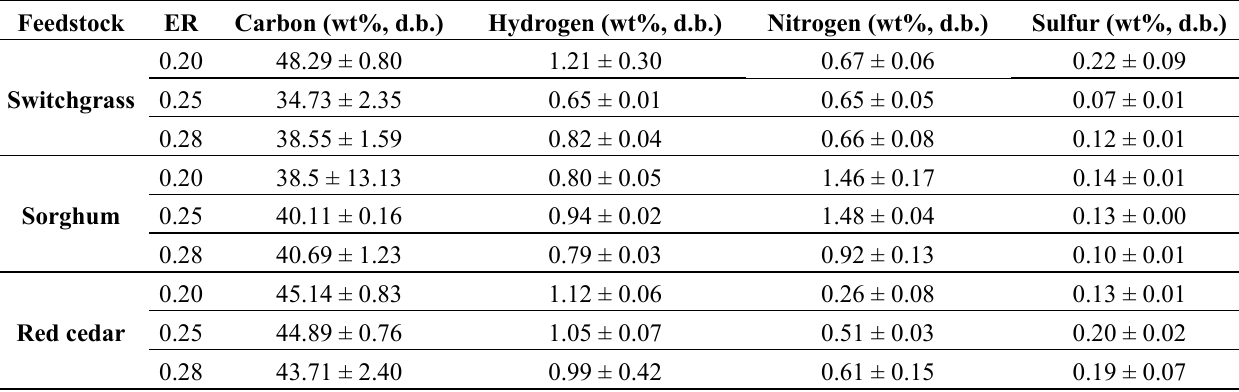
Table 3. Elemental composition for char derived from switchgrass, sorghum and red cedar at three equivalence ratios